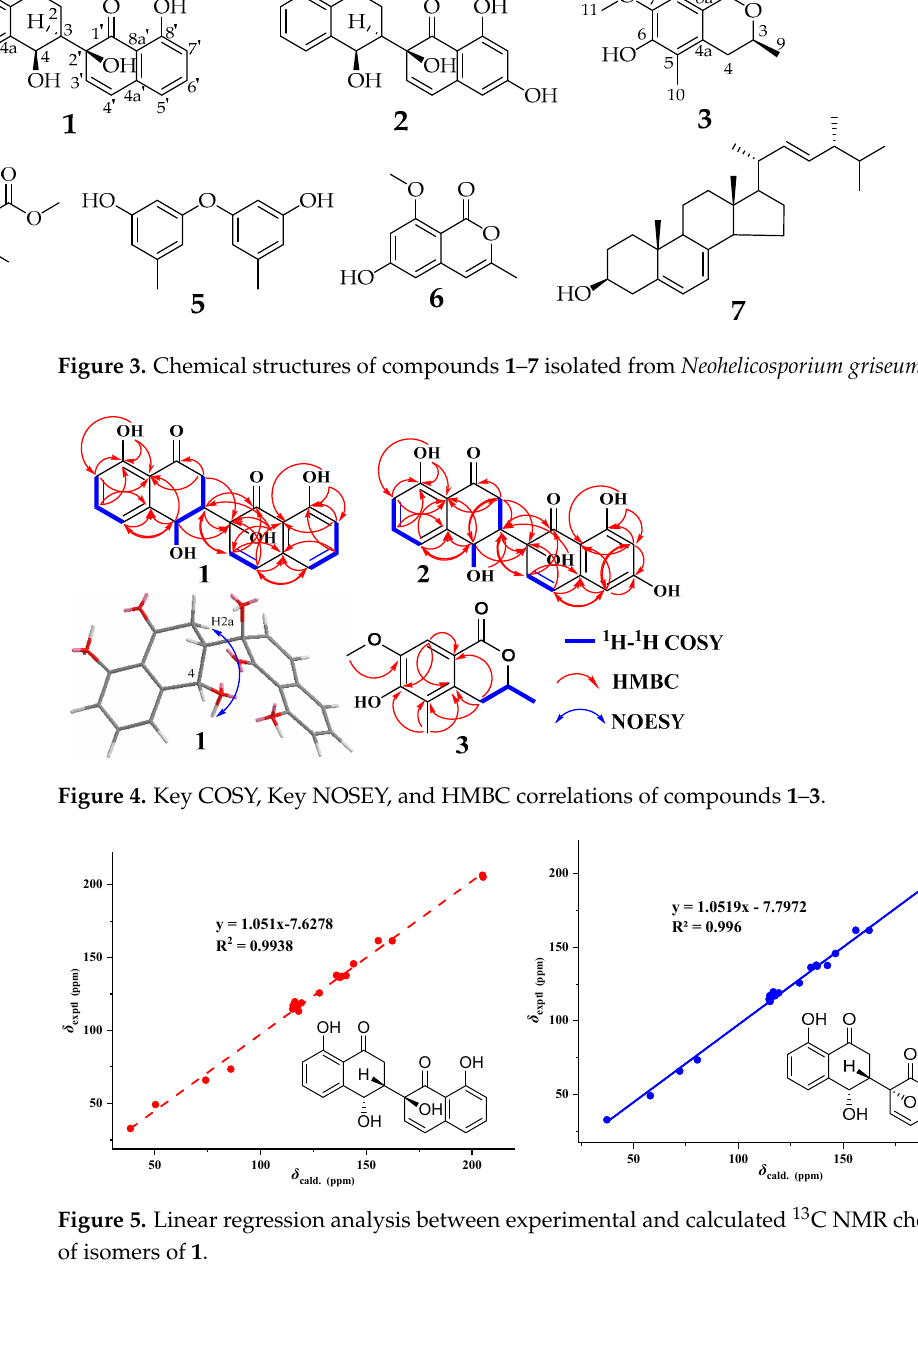
Figure 6. Calculated and experimental ECD spectra of compounds 1 and 2. Compound 2 (Figure 3) was obtained as a brownish-black solid, and its molecular formula was established as C 20 H 16 O 7 based on HRESIMS data at 391.07761 [M+Na] + (calcd. for C 20 H 16 O 7 N a , 391. 078824), indicating 13 degrees of unsaturation. The molecular formula of compound 2 has only one more oxygen atom than compound 1 , and the 1 H-NMR spec- trum is very similar, except for one less aromatic proton and one more exchangeable pro- ton, suggesting that compound 2 has only one more phenolic hydroxyl group (10.94, s, 1H) than compound 1 . The 1D and 2D NMR data of the left part of compound 2 are almost identical to those of compound 1, indicating they share the same planar structure and relative configuration of the left part (Figures S10–S15). The 1 H-NMR data of compound 2 showed the two protons [6.31, (d, J = 2.2 Hz, 1H), 6.17, (d, J = 2.2 Hz, 1H)] were meta- coupling on the right benzene ring. The HSQC correlations of H-5 ′ /C-5 ′ , H-7 ′ /C-7 ′ , along